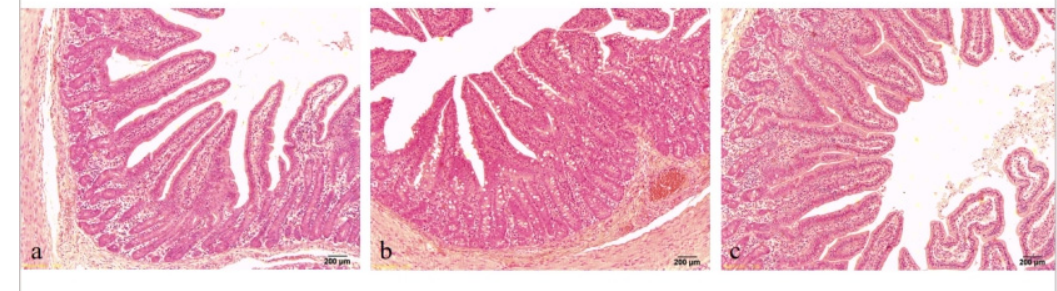
Figure 1. Effects of dietary supplementation of coated cysteamine on jejunal morphology (HE × 40) in pigs induced by diquat. ( a ) Control group; ( b ) Diquat group; ( c ) Cys + diquat group. Scale bar: 200 μ m. Table 6. Effects of dietary supplementation of coated cysteamine on jejunal morphology of pigs induced by diquat.